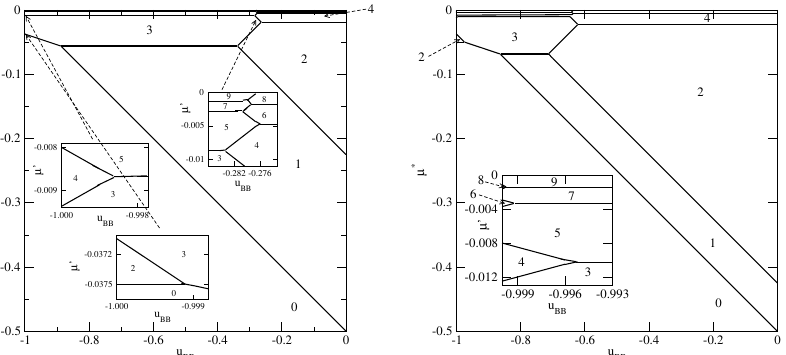
Figure 11. The ground state phase diagrams for the systems with V A = − 1.0 and V B = − 0.6 ( left panel) and with V A = − 1.0 and V B = − 0.8 ( right panel). The numbers mark the numbers of layers stable in different